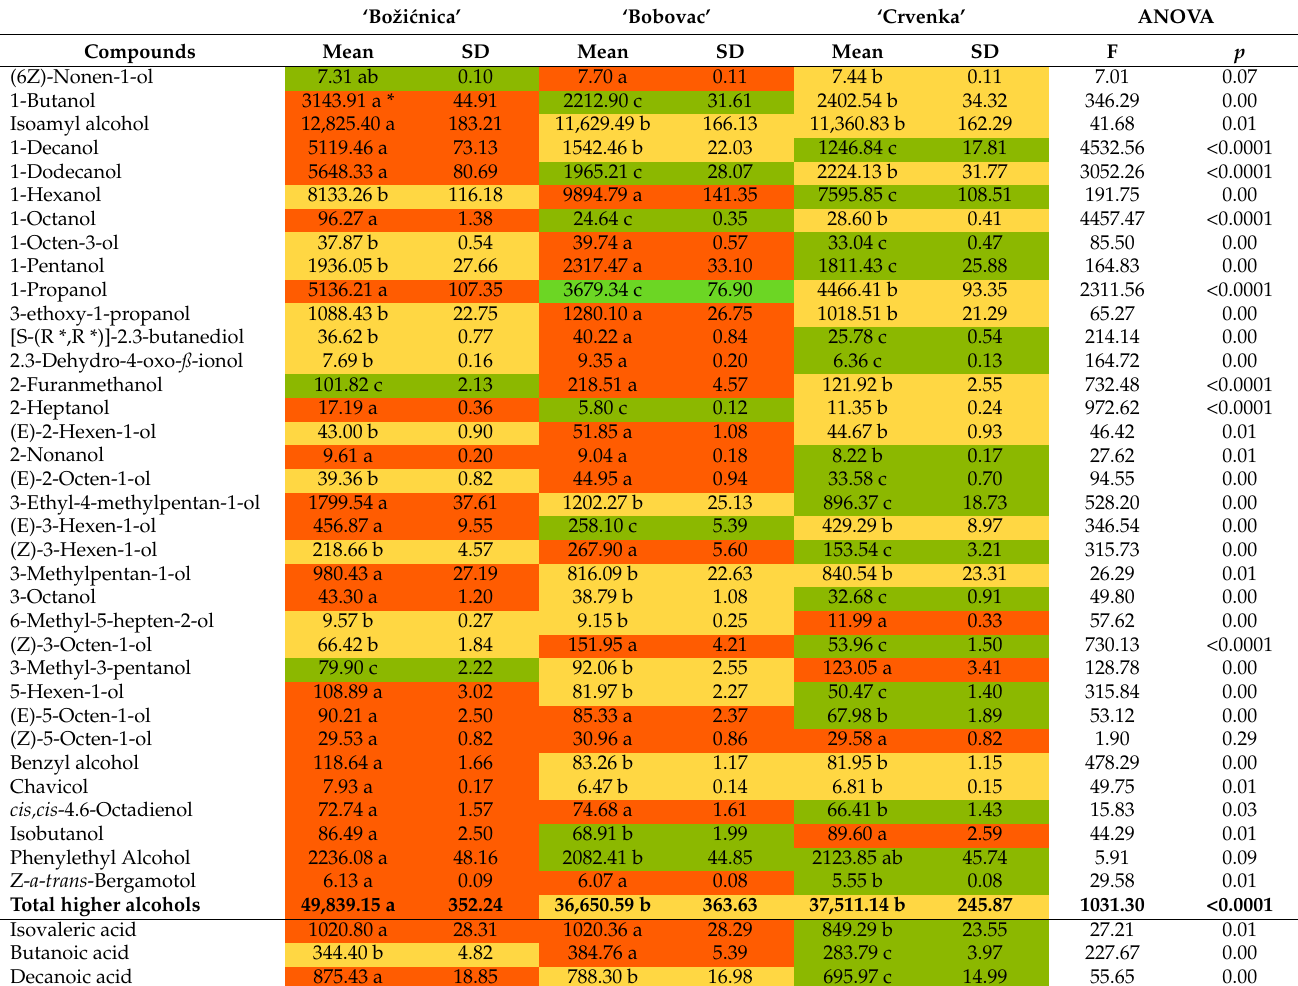
Table 4. Concentration of aromatic compounds in P é t-Nat ciders ( µ g · L − 1 ).